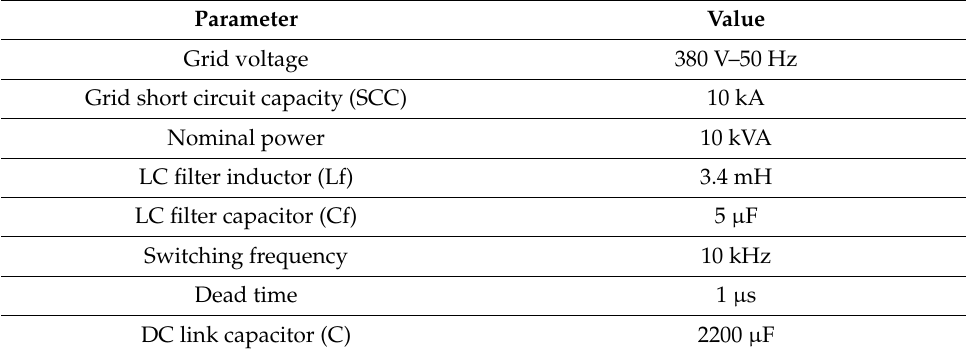
Figure 10. Processor-in-the-Loop (PiL) setup. Table 2. 2L-VSC